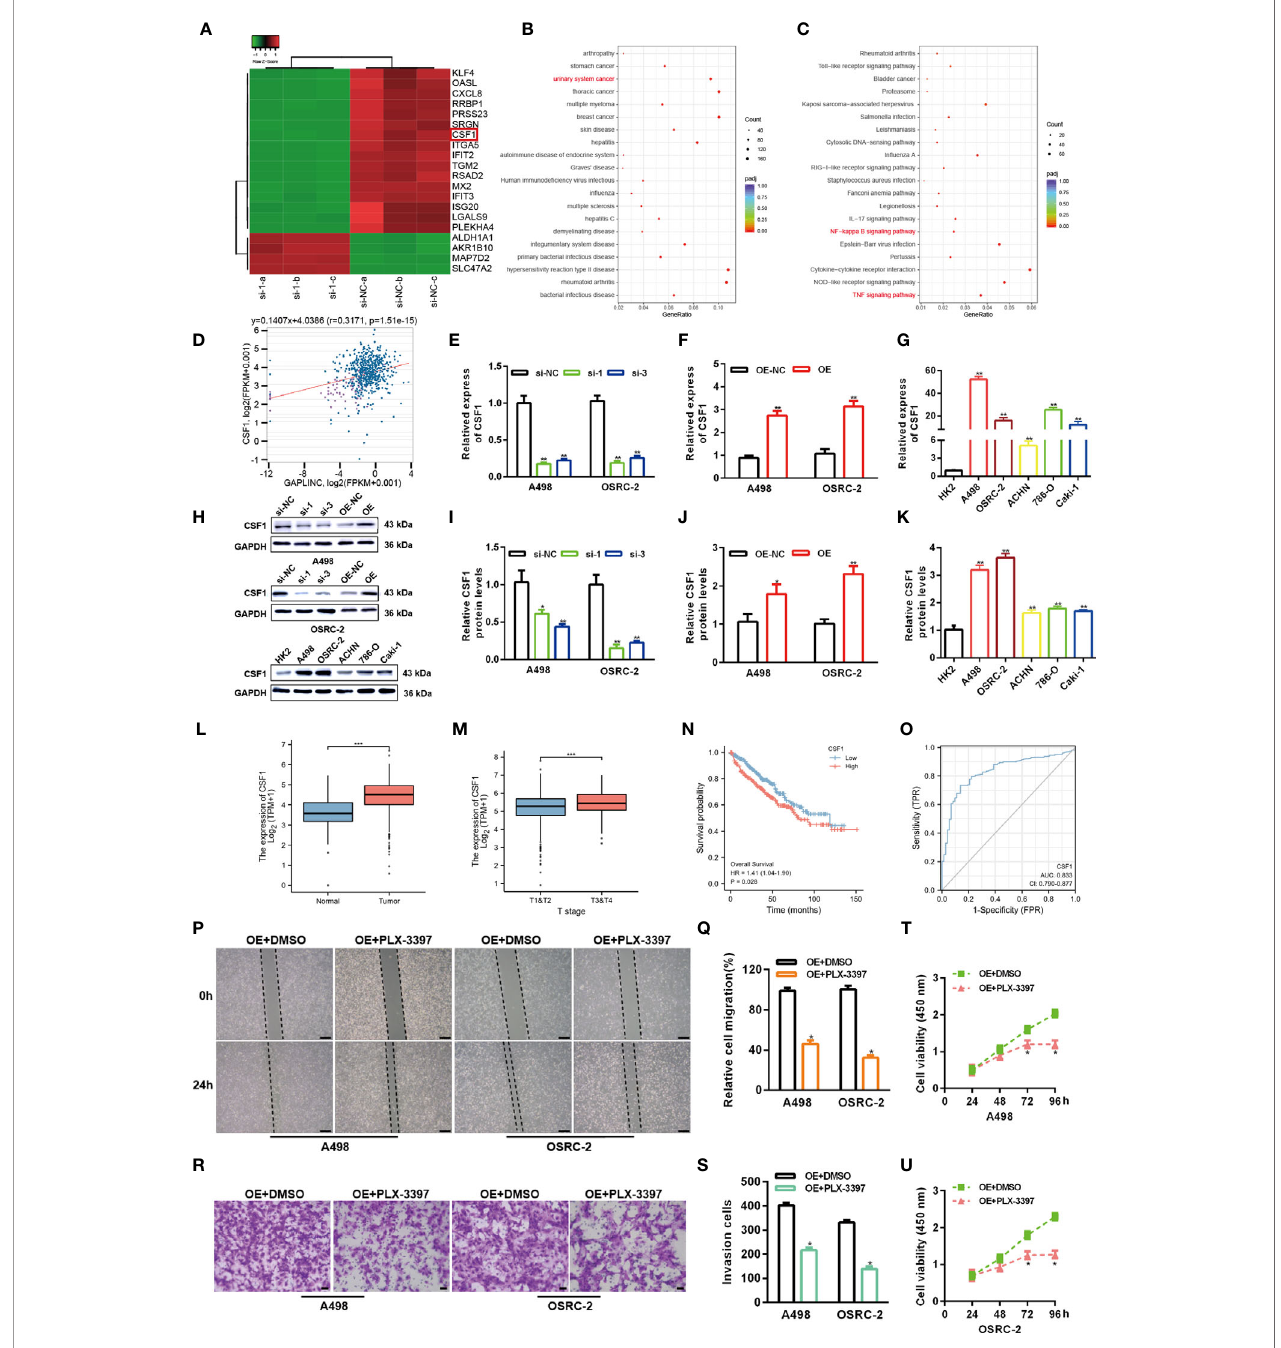
FIGURE 3 | GAPLINC facilitates RCC progression by enhancing CSF1 expression. (A) Heat map showing the top 20 transcripts that are altered in A498 cells following GAPLINC silencing. (B) DO and (C) KEGG enrichment analysis of the differentially expressed genes upon GAPLINC knockdown. (D) Pearson correlation analysis between GAPLINC levels and CSF1 levels in RCC tissues according to an online database (http://rna.sysu.edu.cn/chipbase/). CSF1 expression by RT-qPCR after silencing (E) or overexpressing (F) GAPLINC in A498 and OSRC-2 cells. (G) Expression level of CSF1 mRNA in HK-2 and RCC cells measured by RT-qPCR. (H – K) Western blotting analysis of the expression of CSF1 protein after silencing or overexpression of GAPLINC and the expression of CSF1 protein in HK-2 and RCC cells. (L) TCGA cohort analysis of CSF1 expression levels in RCC samples and adjacent normal tissues. (M) CSF1 expression levels in patients with different tumor stages of RCC (TCGA). (N) Kaplan-Meier OS curves according to CSF1 expression level. (O) The sensitivity and speci fi city of CSF1 were assessed using ROC curve analysis. Effects of the CSF1 inhibitor PLC-3397 on the migration and proliferation of GAPLINC-overexpressing RCC cells according to wound closure (P, Q) (scale bars = 200 m m), Transwell (R, S) (scale bars = 50 m m) and CCK-8 assays (T, U) . *p < 0.05; **p < 0.01; ***p <